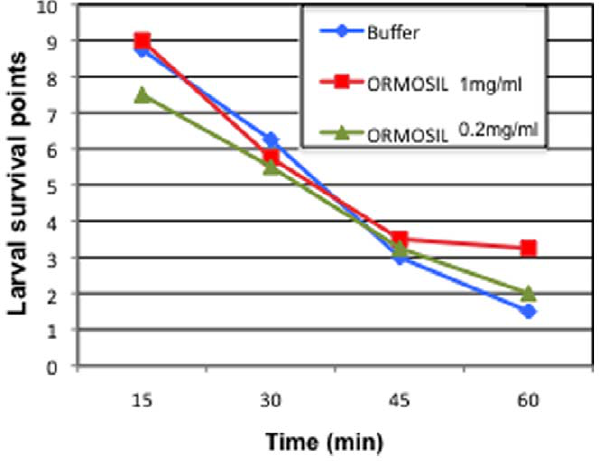
Figure 3. The short-term survival of dissected living larvae is not affected by ORMOSIL nanoparticles. Dissected living larvae were treated with R ORM (1 mg/ml and 0.2 mg/ml are shown) or buffer and larval survival was quantified by evaluating the